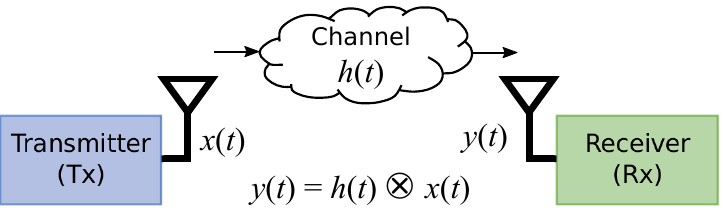
Figure 2. Illustration of wireless channel, where the channel impulse response (CIR) is indicated by h ( t )